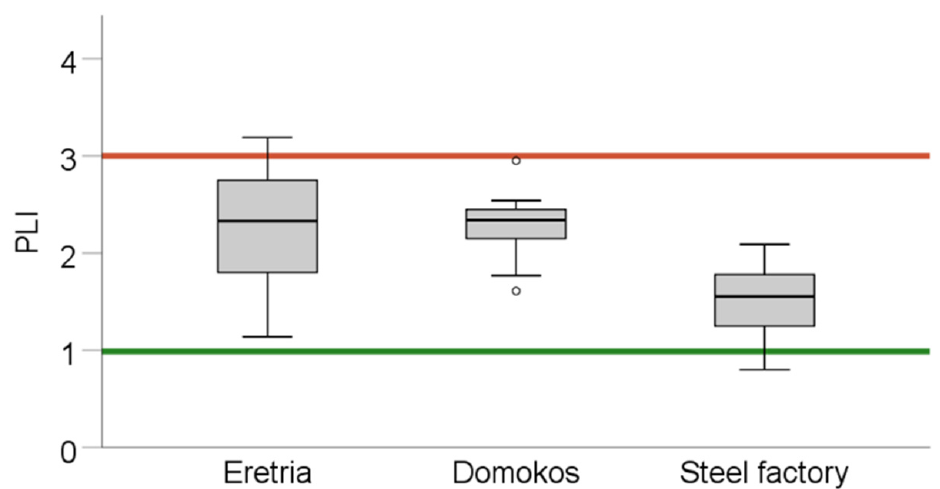
BG = background content of trace elements in earth crust, TAV = trigger action values, MAC = maximum allowable concentrations.